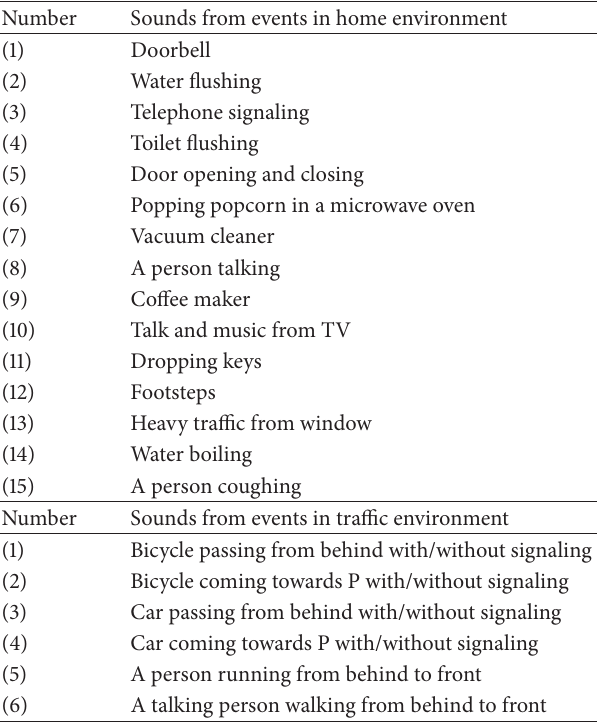
Table 3: Sounds from events used in the tests in home and traffic